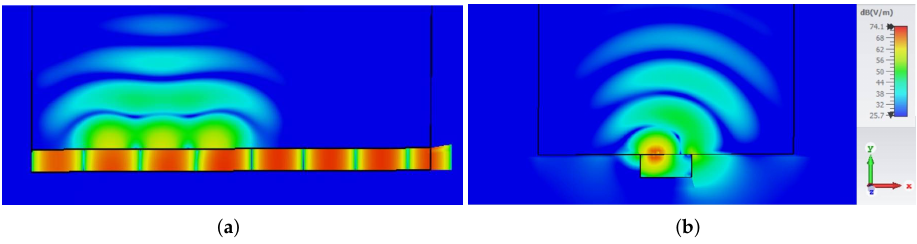
Figure 17. Antenna radiating into the human body—snapshot of a moment in time of the E-field distribution: ( a ) H-plane cross-section, ( b ) E-plane cross-section. The black frame indicates the cuboid